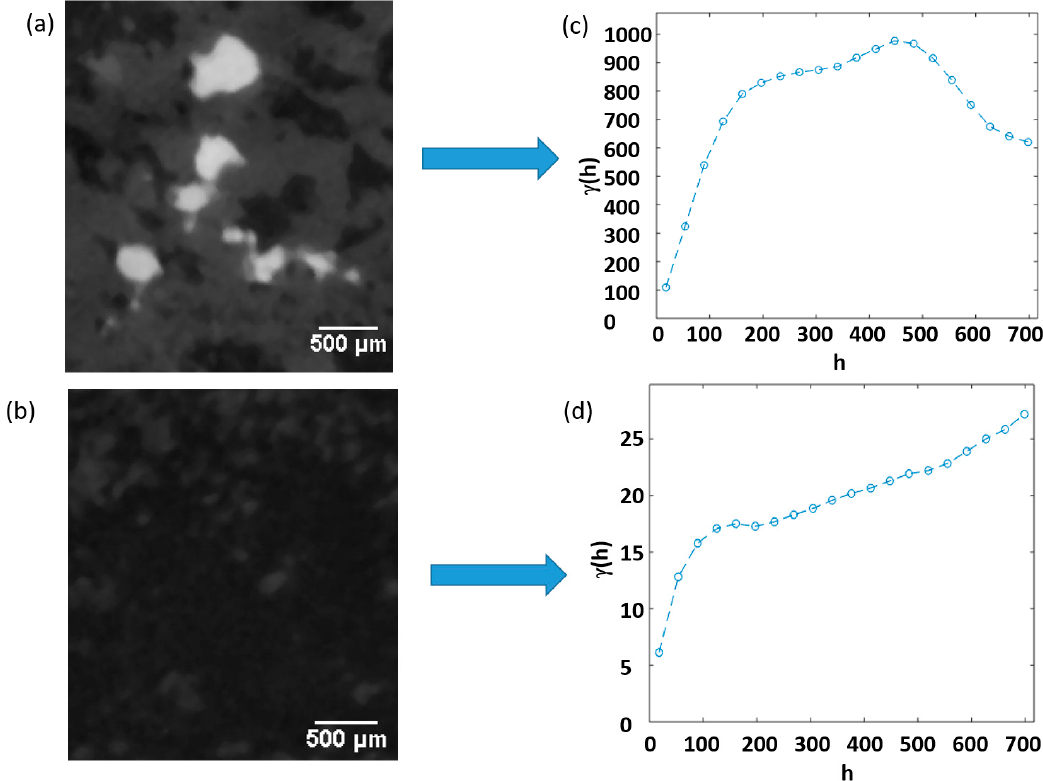
Figure 12. Semi-variogram for different textures, computed using a total 10,000 points in the texture. The variogram explains the relation between the variance ( γ (h)) against the distance of two points in the texture (h), grouped in a bin width of 20. Texture ( a ) is more varied than ( b ), which explains the higher variance in the variogram ( c ) in comparison to ( d ). The variogram of texture ( a ) exhibits a cyclic nature due to the somewhat periodical occurrence of sulphide phases. Texture ( b ) exhibits upward trend in variance due to occurrence of amphiboles (light grey) in the top part of the texture.